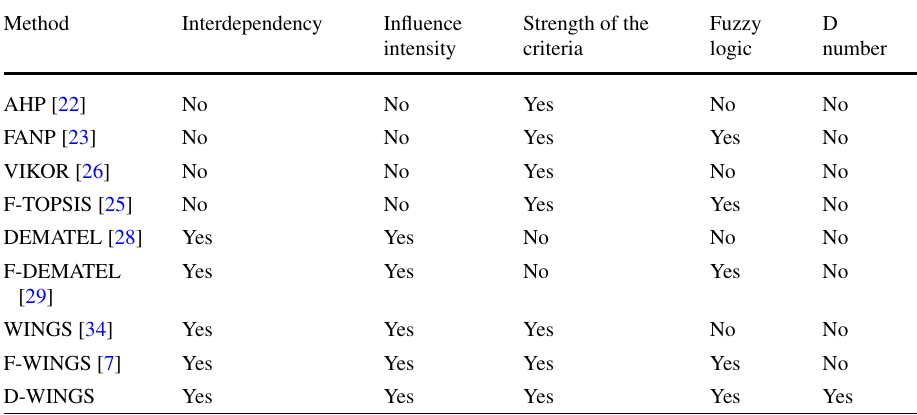
Table 1 The comparison of the different methods